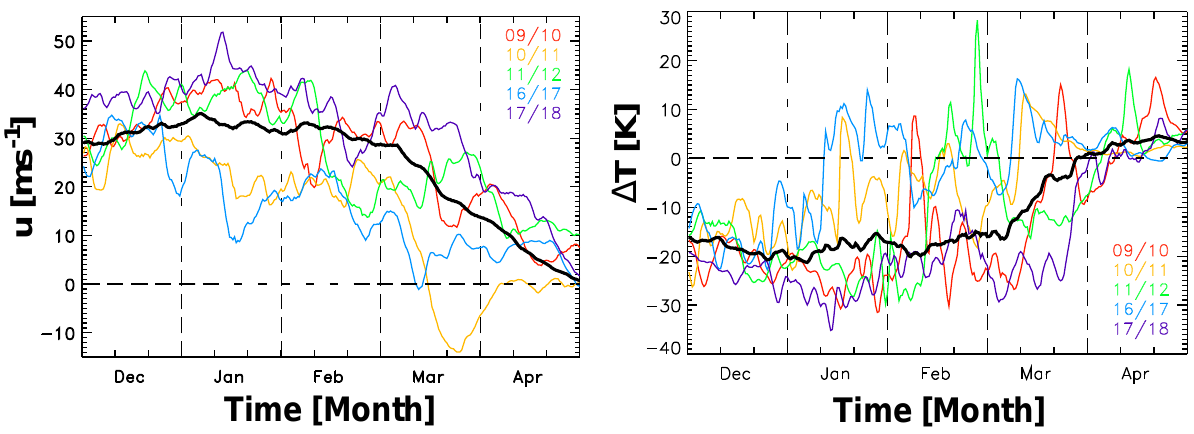
Fig. 5. 12-hourly averages of the modeled zonal means of the zonal wind at 60 ◦ N, 30 hPa (left panel), and of the temperature difference between North Pole and 60 ◦ N, 30 hPa (right panel) during winter and spring. Black lines represent the averages over 20 simulated years. Colored lines represent five selected model years with distinct dynamic conditions (see